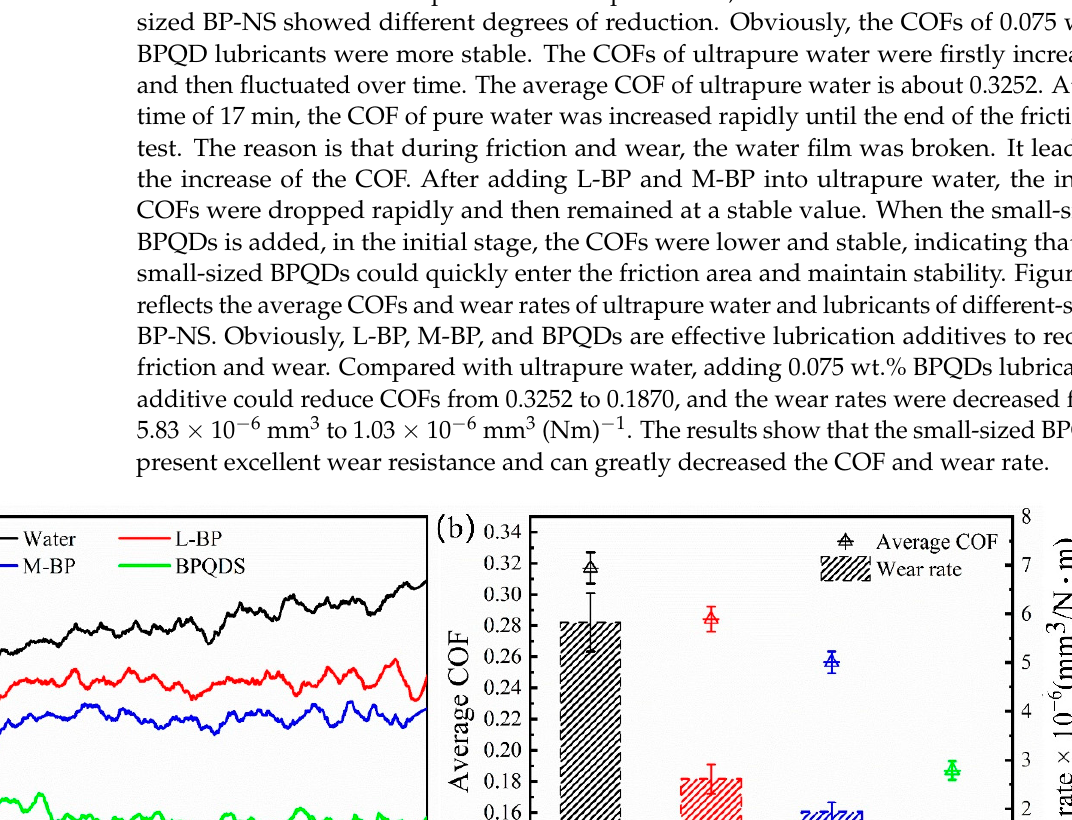
Figure 6. Average COFs and wear rates as a function of BPQDs concentration as water-based lubri- cation additives (10 N, 150 r/min, 0.5 h). The tribological properties of different-sized BP-NS under different loads were in- vestigated, as shown in Figure 7a. For ultrapure water, the COFs of L-BP and M-BP were decreased with increasing load. When the loads were increased from 10 N to 15 N, the average COFs of BPQDs increased slightly, although they were still lower than that of